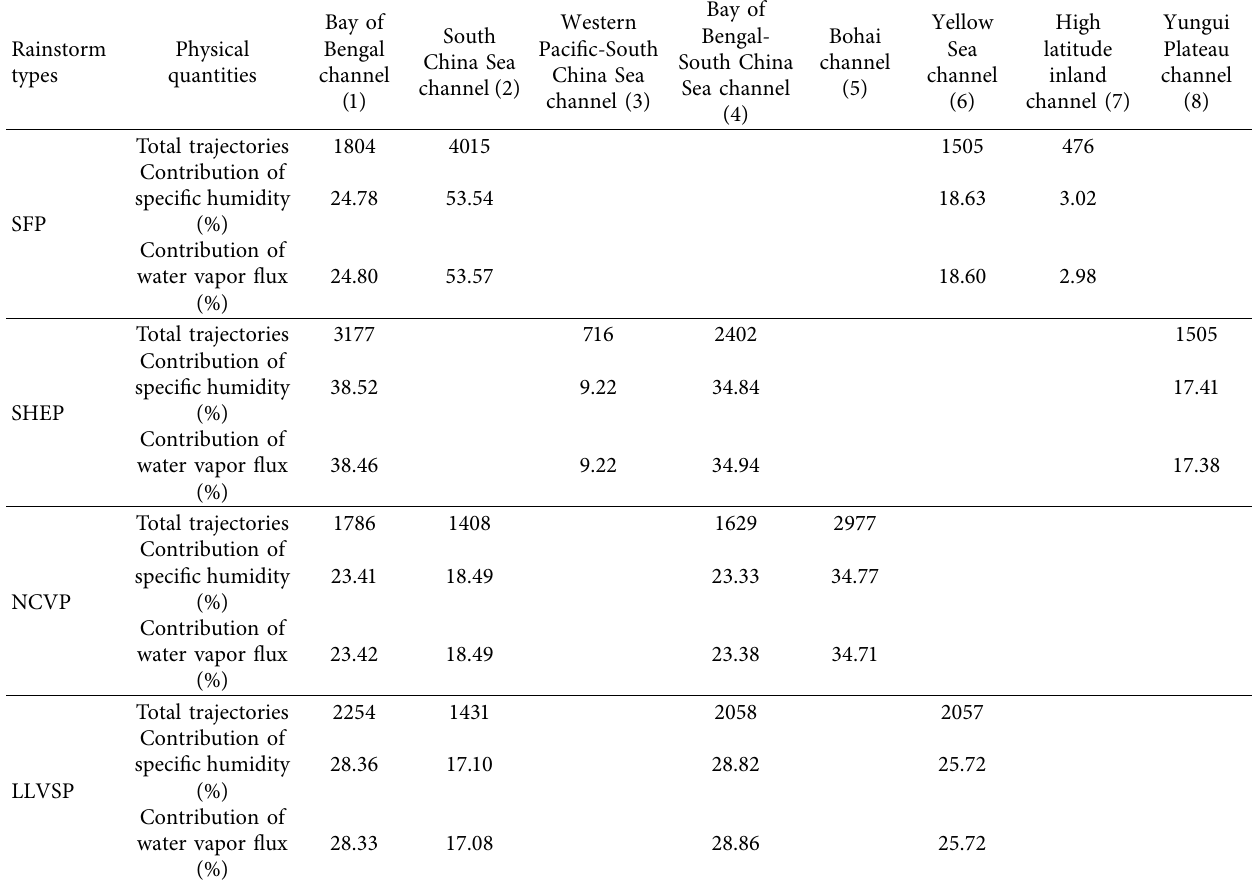
Table 1: The total number of trajectories and contribution of specific humidity and water vapor flux on the lower levels of different types of